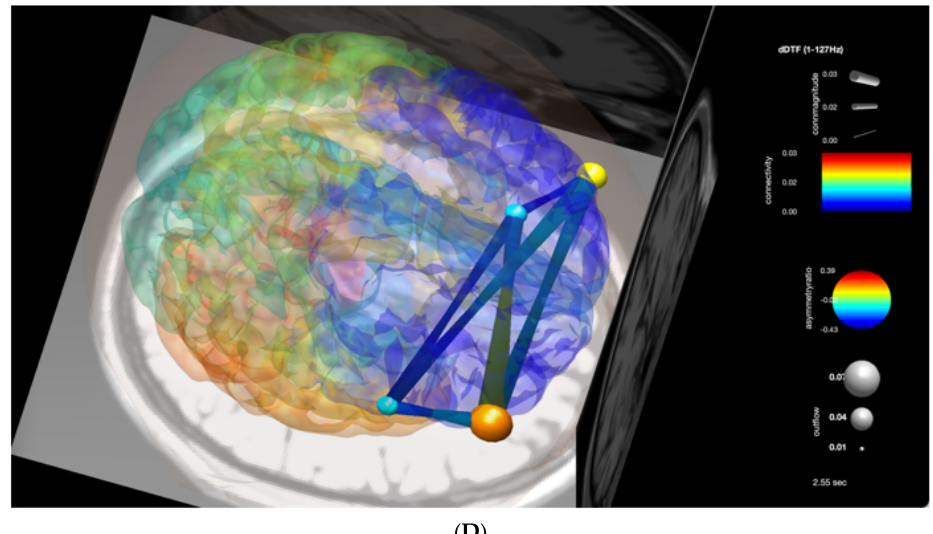
Figure 2. ( A ) 3D oral scanner study performed after positioning the provisional new implant. Points of dental inter arch pressure by color-coded depiction (red as maximum altered dental pressure, green as minimal) show the strong reduction of the spots of dental abnormal pressure as a shift of the red points towards green colors. ( B ) Three hours after positioning the provisional implant: LORETA assessed current density dipole field evenly distributed between the frontal-parietal areas. Red color indicates maximum current density, deep blue the minimum. The distribution of the current fields between the frontal-parietal areas now appears evenly distributed. ( C , D ) (after provisional and definitive implant, respectively). Granger causality exploited by the normalized directed transfer function (DTF) at 6290 of 8000 ms. of EEG recording. The effective connectivity rendering is represented by the anterior full red circle which correlates with the almost symmetric distribution of causality between the frontal-parietal hubs, represented by the red circles (hubs) and the yellow lines of connections (edges).